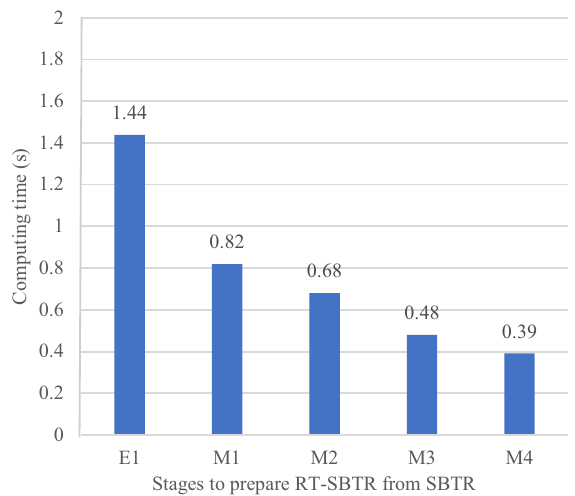
Fig. 16 Total computing time to execute the simulation of 1 s at different stages of preparing RT-SBTR from SBTR